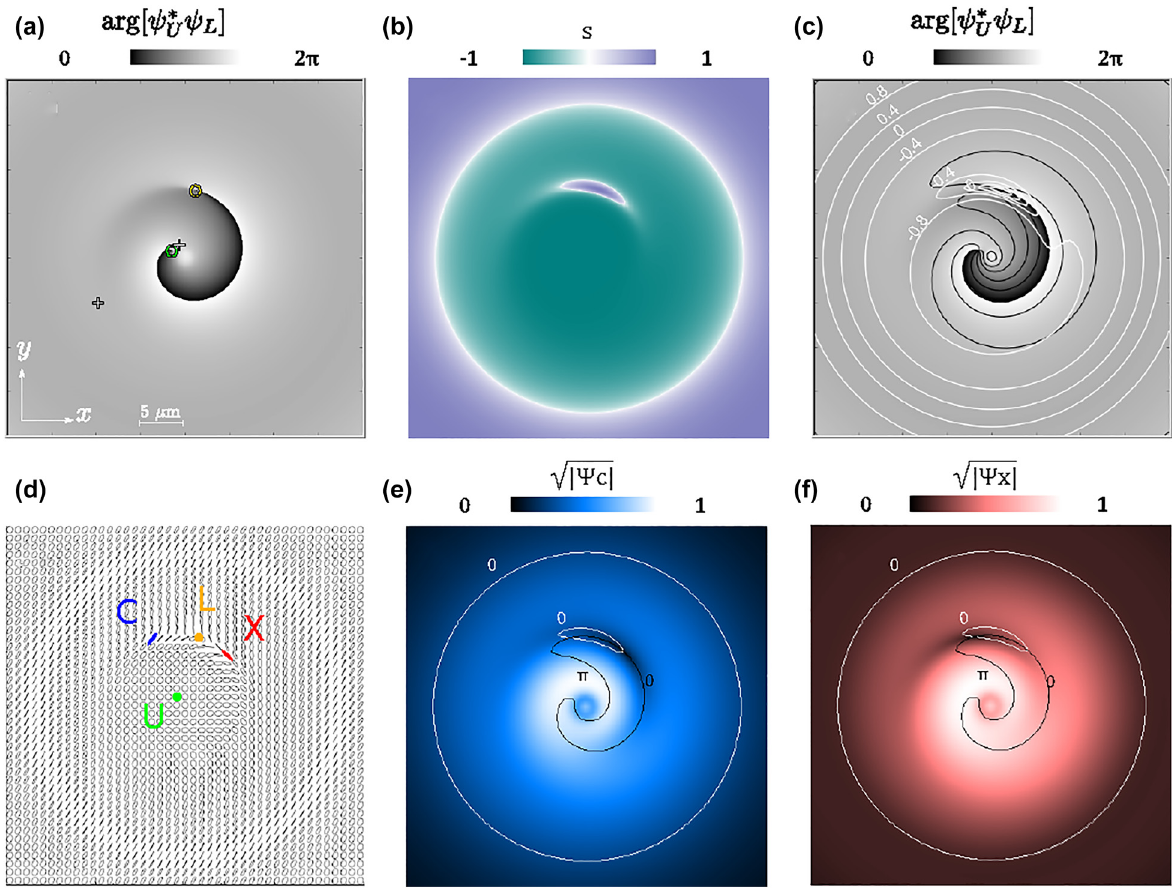
ψ [ ] andamplitude s = {| ψ U | 2 −| ψ L | 2 } L U {| ψ U | 2 +| ψ L | 2 }